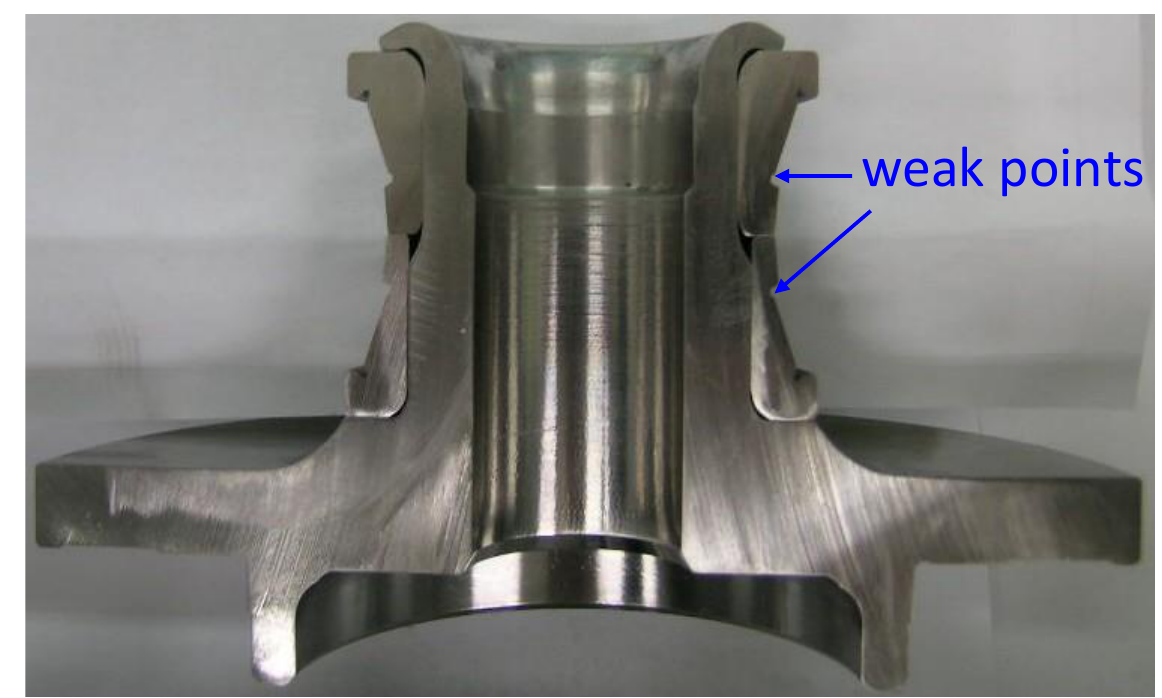
Figure 1. Cross-section of the wheel-bearing unit in this study.